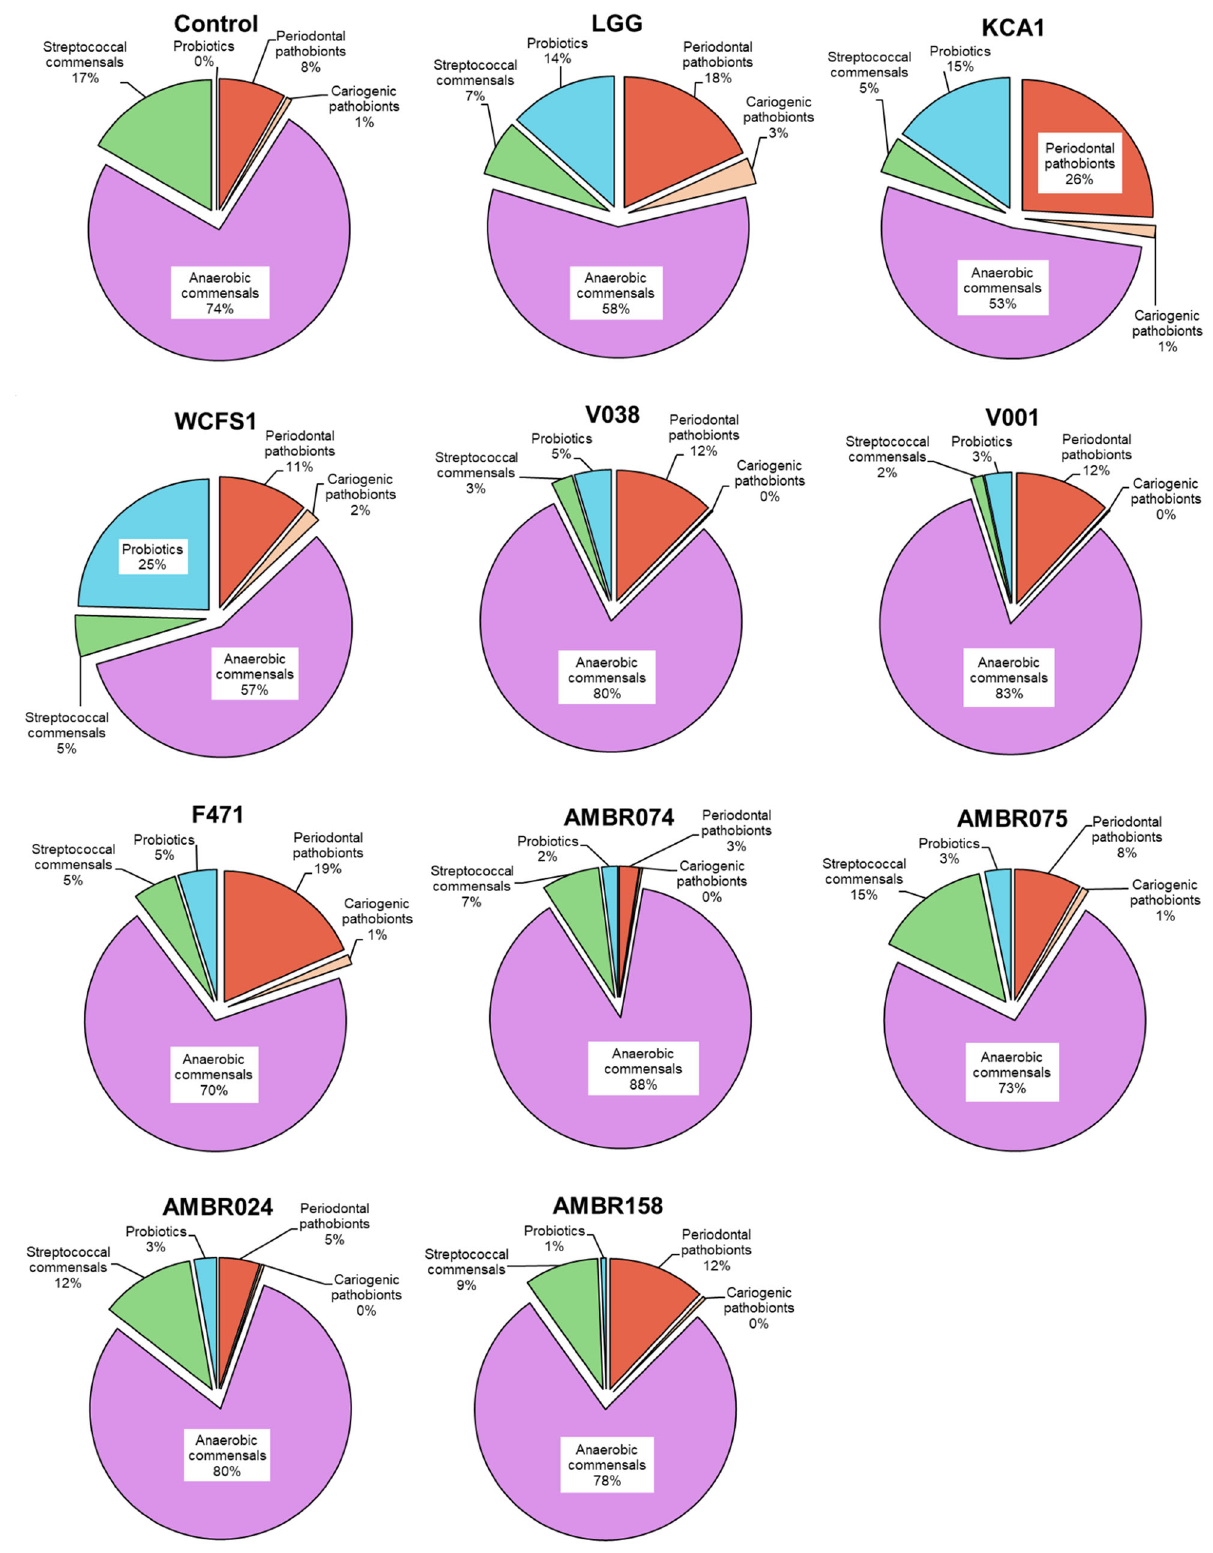
Fig. 4 Probiotic effects on the proportional composition of the bio fi lms. Combined data of Figs. 1 & 2 presented as pie charts of the percentage composition of these bio fi lms divided into probiotics, periodontal pathobionts, cariogenic pathobionts, anaerobic commensals and streptococcal